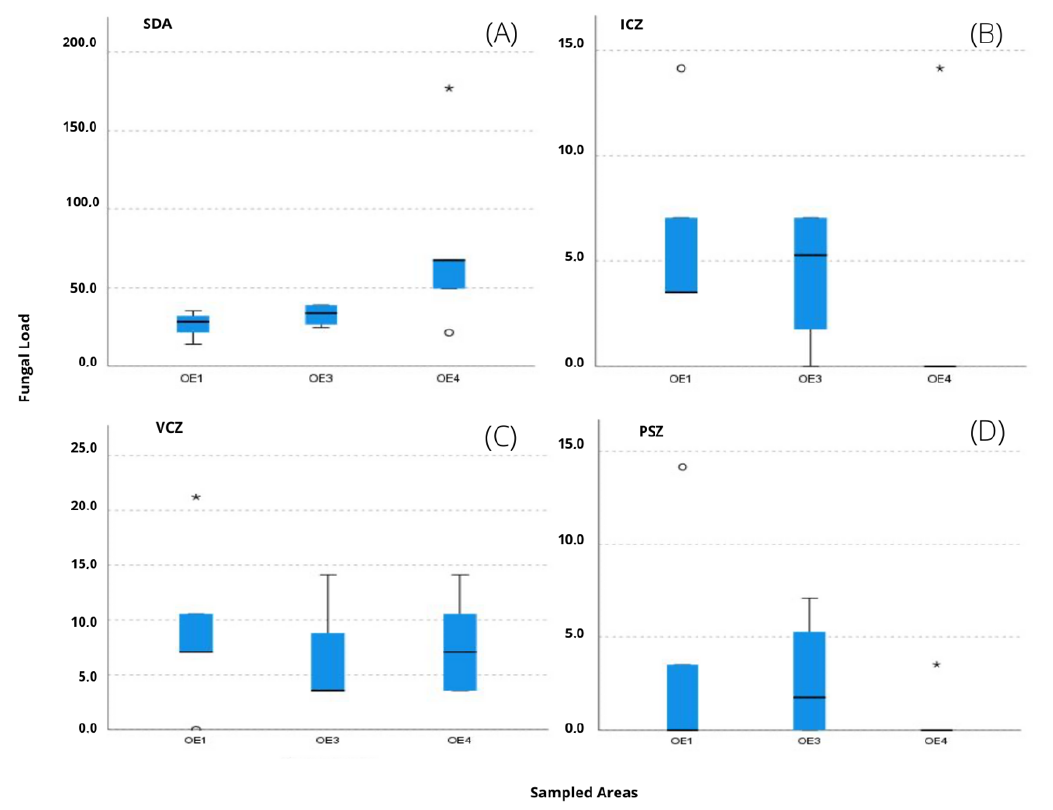
Figure 8. Boxplot for comparison of fungal load in SDA ( A ), ICZ ( B ), VCZ ( C ) and PSZ ( D ) between sampled areas (excluding the sculpture area (OE2), since it has a single record). Please note the different scales used. * severe outlier; ◦ moderate outlier.